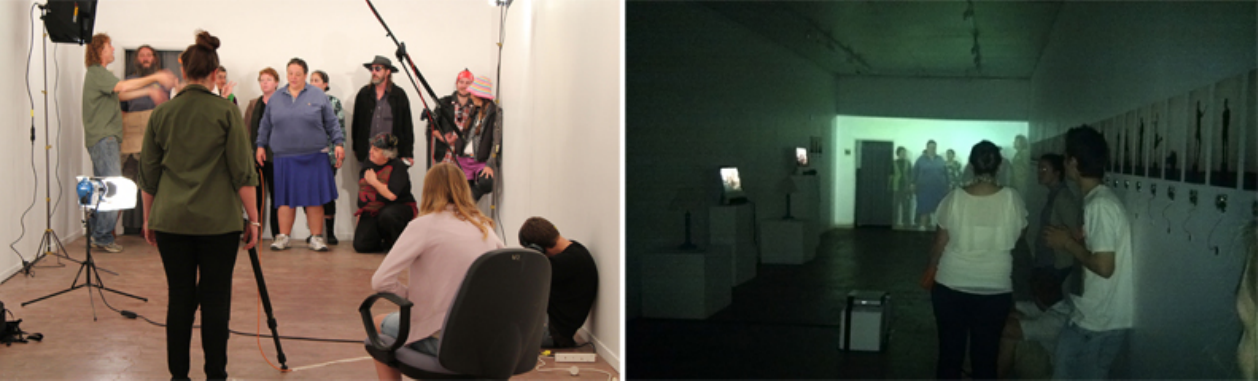
Figure 1: Filming and projecting ‘Up Against